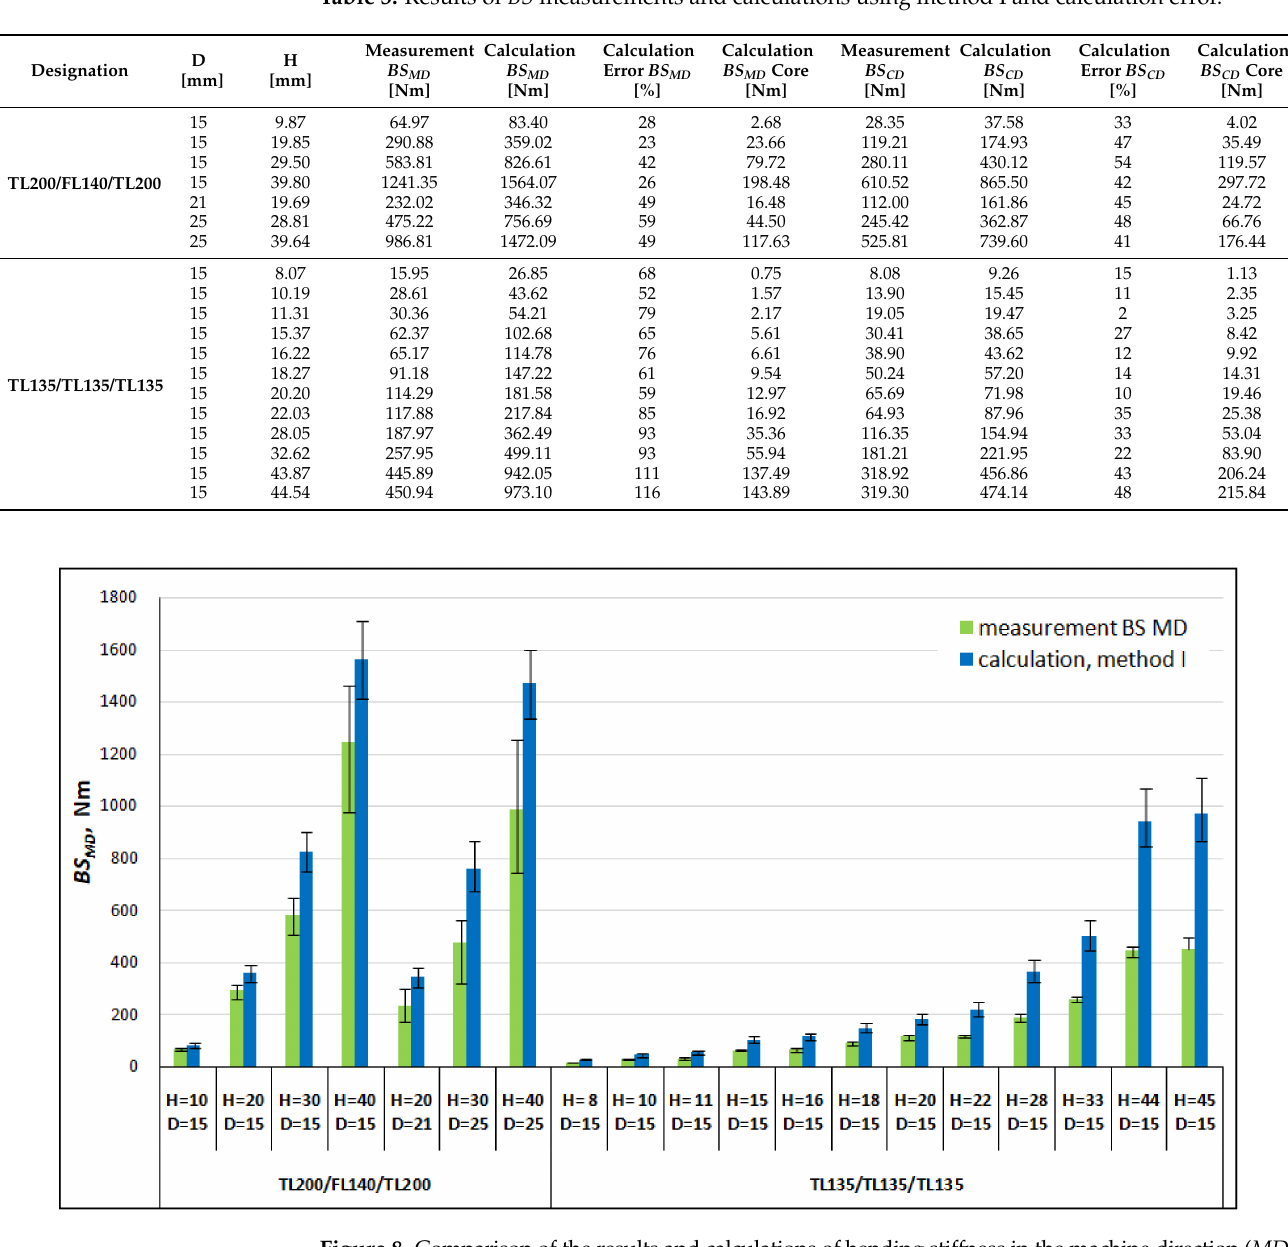
Figure 8. Comparison of the results and calculations of bending stiffness in the machine direction ( MD